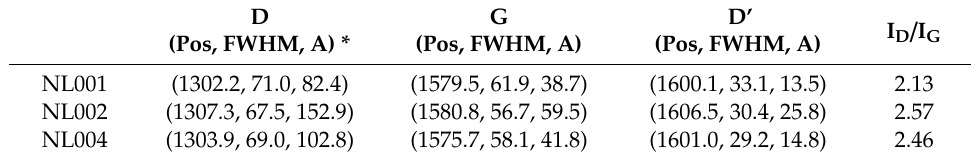
Table 1. The profile characteristics of D, G, D’ Raman bands the intensity ratio (I D / I G